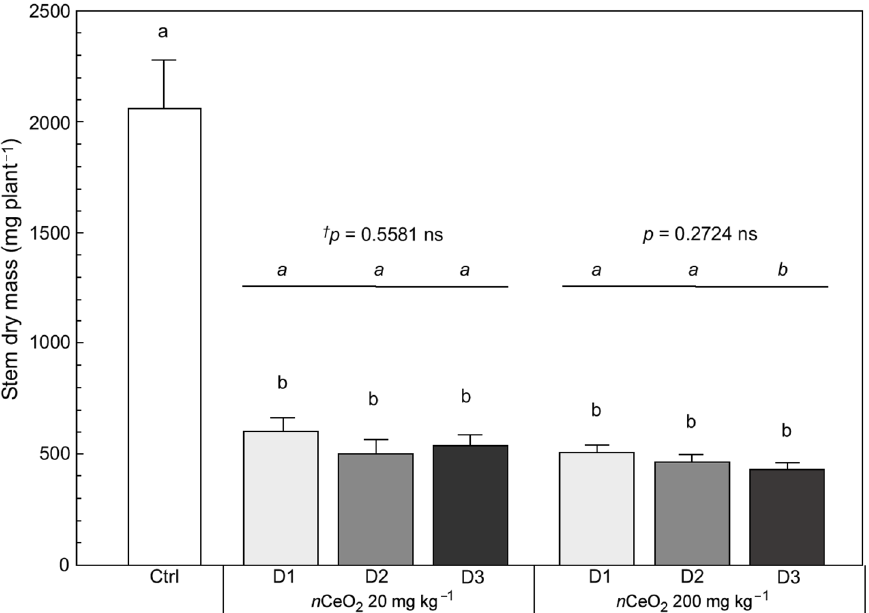
Figure 5. Stem dry mass of S. flos cuculi . Comparison of effects based on single (D1) and repeated applications (D2, D3) of 20 and 200 mg kg − 1 n CeO 2 , respectively. Letters indicate statistically significant difference between treatments ( p ≤ 0.05) using one-way ANOVA followed by Tukey’s test. † One-way ANOVA p -value within each concentration.